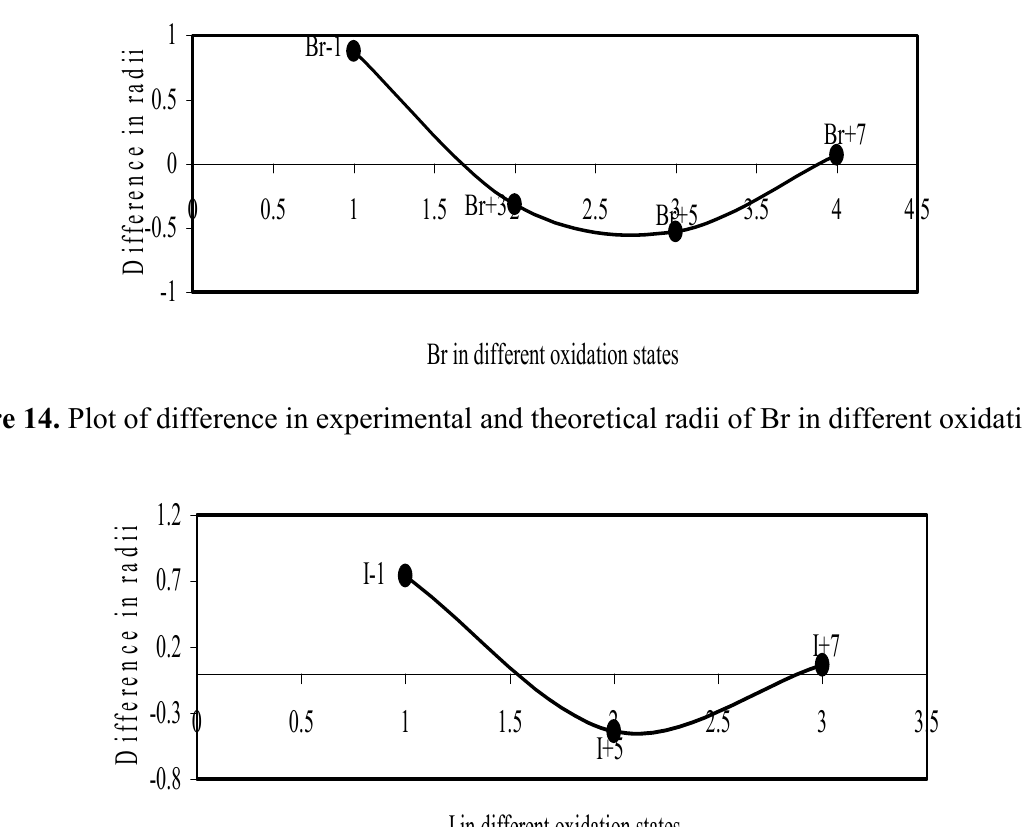
Figure 15. Plot of difference in experimental and theoretical radii of I in different oxidation states.